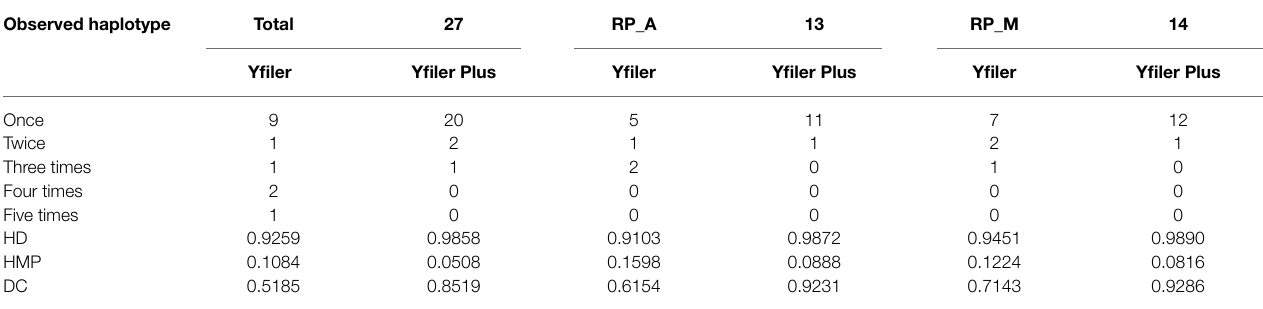
TABLE 3 | Diversity indexes for the whole analyzed samples from Roccapelago, and for the ancient (RP_A) and modern (RP_M) population sets, separately. Observed